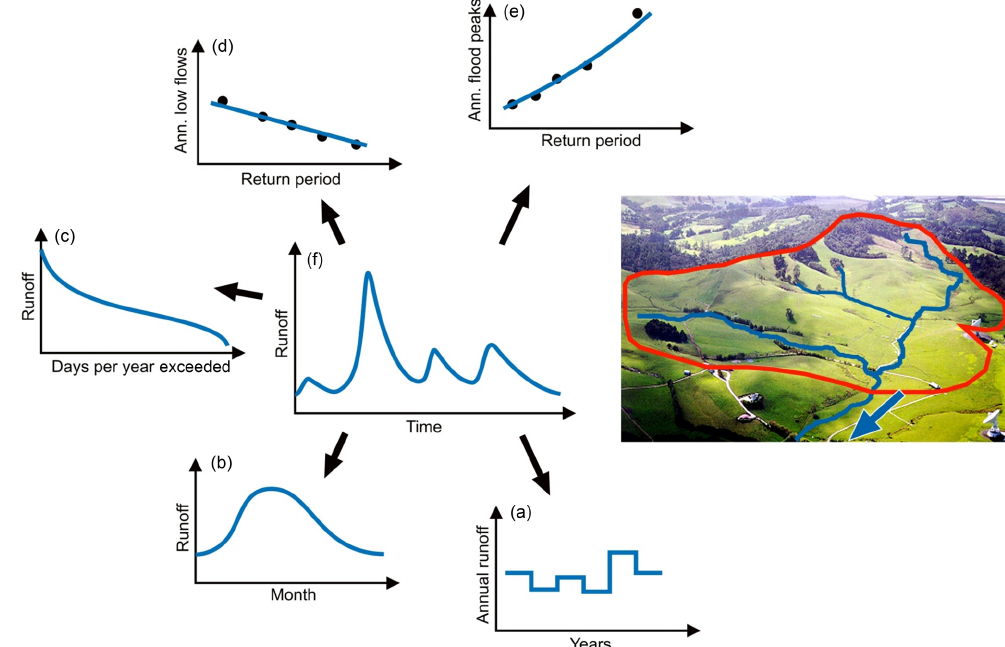
Figure 3. Runoff signatures deemed emergent patterns reflecting the functioning of the catchment ecosystem. (a–f) : annual runoff, seasonal runoff, flow duration curves, low flows, floods, and runoff hydrographs. Taken from Blöschl et al.